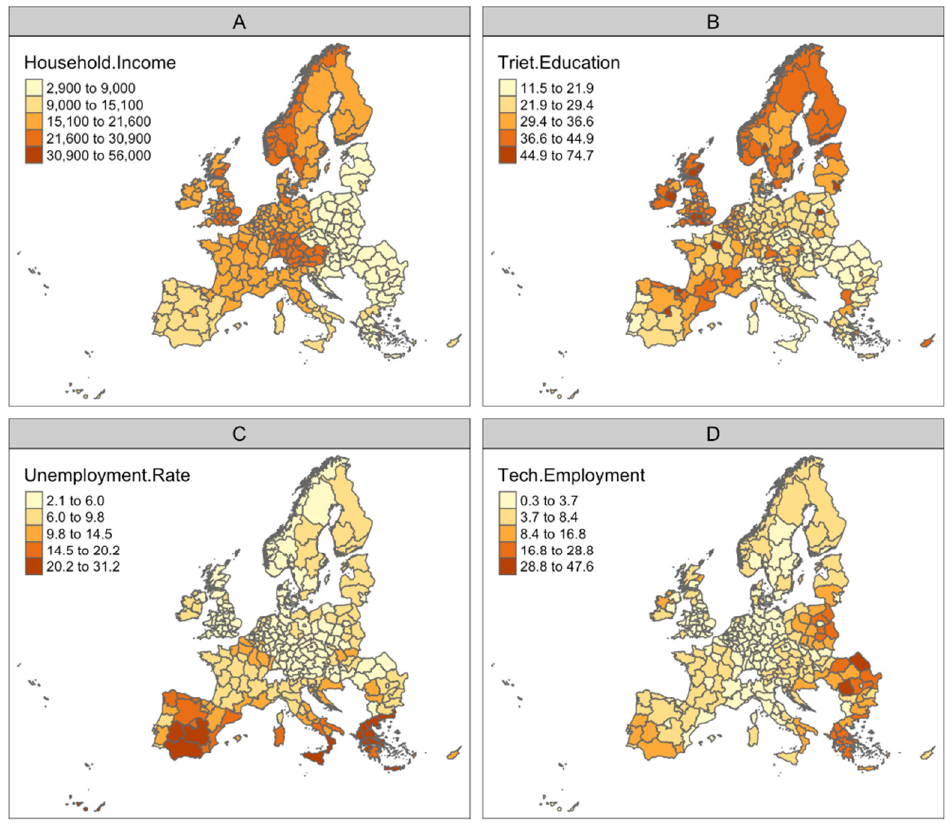
Figure 1. Spatial distribution of the independent and dependent variables used in this study at the NUTS2 level: ( A ) household income, ( B ) tertiary education, ( C ) unemployment rate and ( D ) employment in the tech sector for the year of 2016.